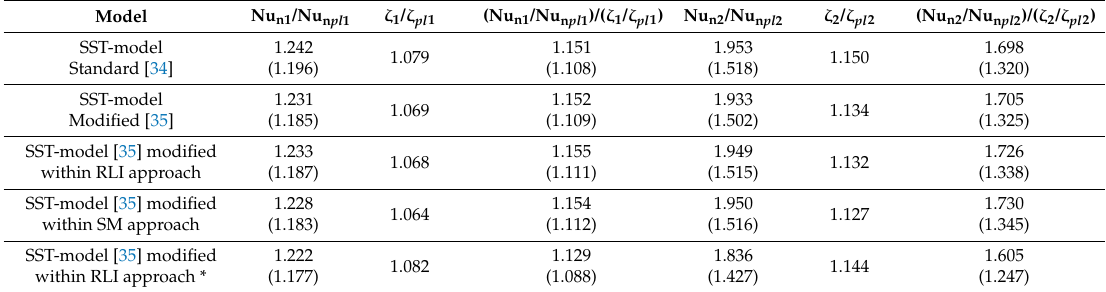
Table 3. Predictions of thermal and hydraulic performance of two sections of the narrow channel with the oval dimple of width b = 0.383 obtained by the modified SST models and different